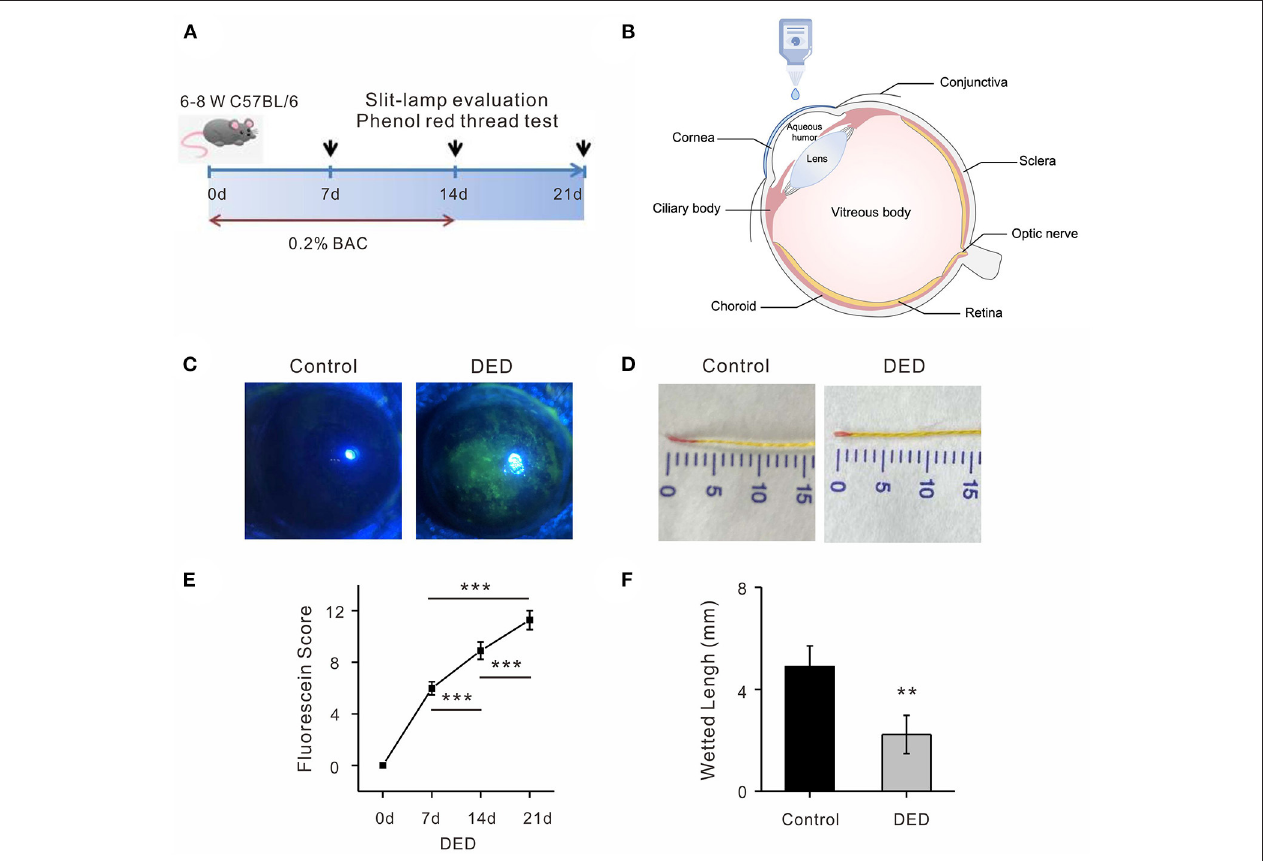
FIGURE 1 | Identification of DED in mouse model. (A) Administration of 0.2% BAC in both eyes for 14 days in DED group. Examinations were taken at day 0, day 7, day 14, and day 21. (B) Topical 5 µ l of 0.2% BAC and PBS were applied twice a day. (C) Representative images of fluorescence sodium staining on day 14 in a DED cornea compared with images of the control cornea. (D) Representative images of tear production on day 14 after DED animal modeling. (E) The fluorescein scores at day 7, day 14, and day 21 were significantly increasing over time in the cornea of the DED mice (all p < 0.001). (F) Significant reduction of wetted length was observed in the DED group compared with the controls ( p < 0.01). DED, dry eye disease; BAC, benzalkonium chloride; PBS, phosphate buffered saline.